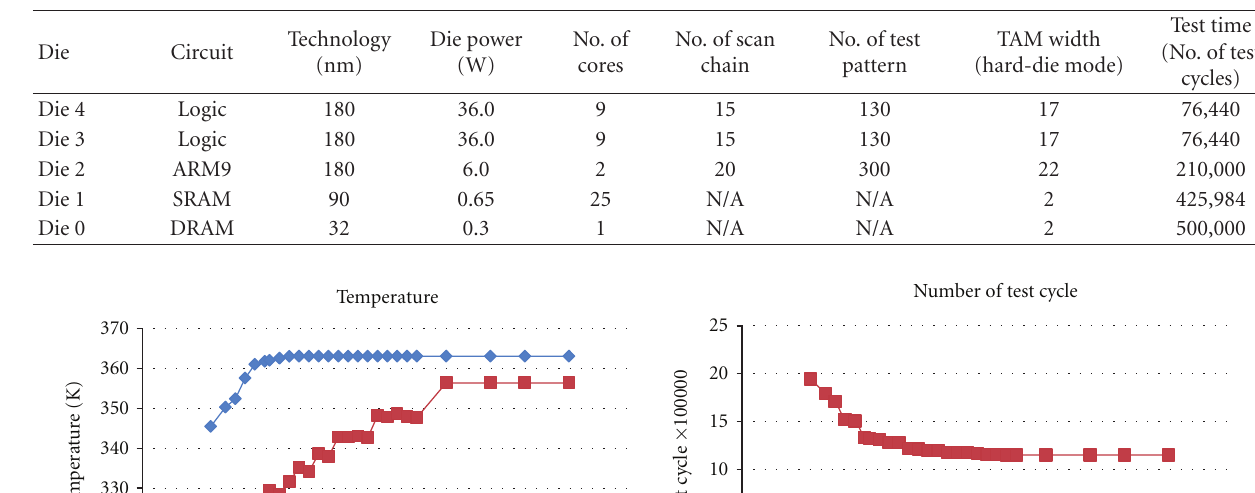
Table 1: The first test case.